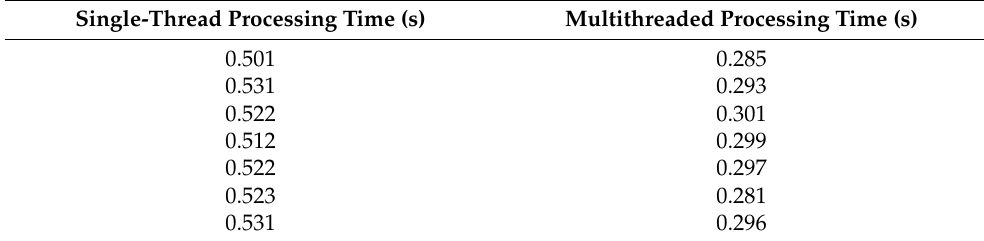
Table 4. Comparison of single- and multithread processing